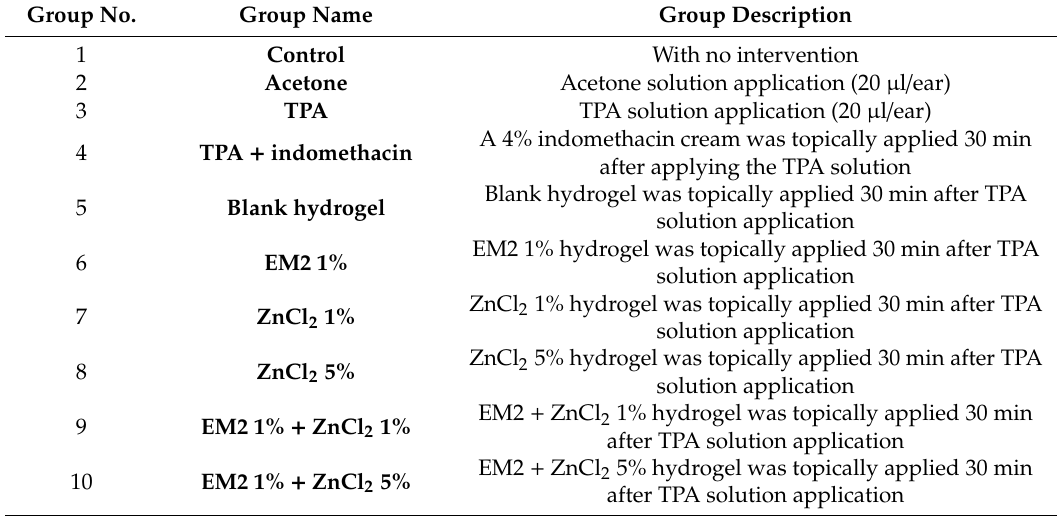
Table 4. In vivo experimental design for the local acute inflammation model. Group